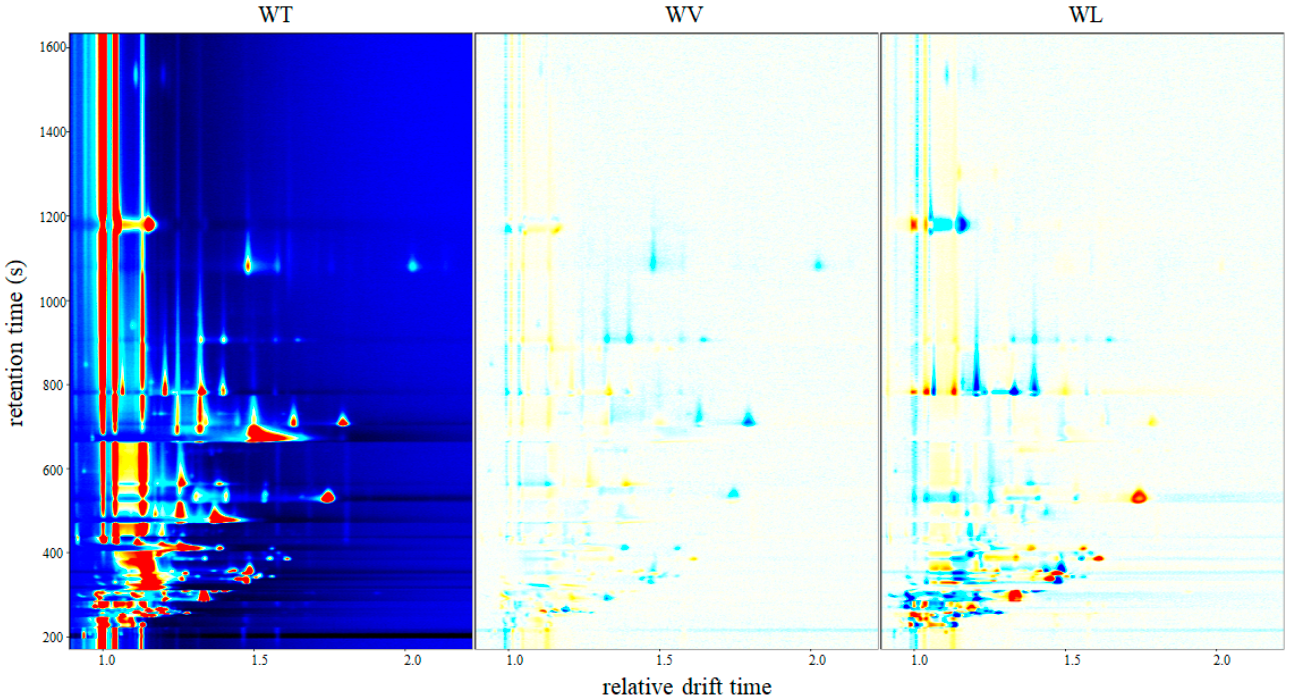
Figure 5. Differences in the three-dimensional (3D)-topographic of volatile compounds in cherry wines derived from three cultivars (WT: cherry wine from cultivar Tieton; WV: cherry wine from cultivar Van; WL: cherry wine from cultivar Lapins).